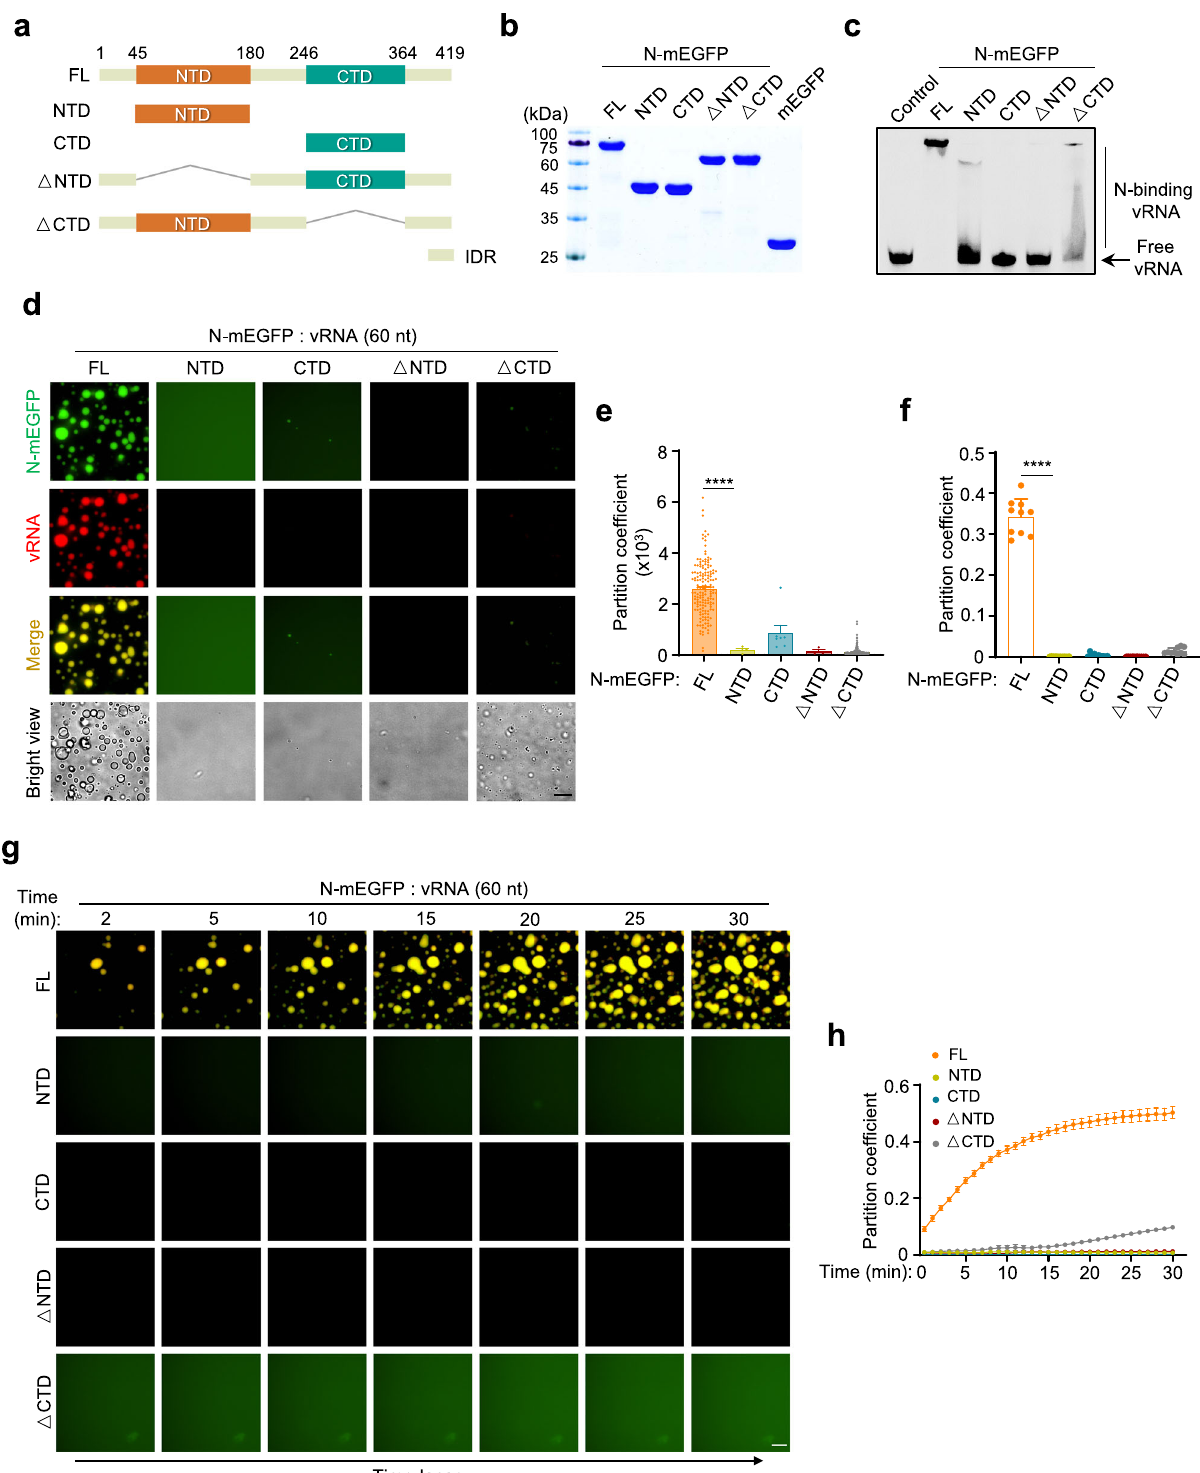
Fig. 3 The LLPS of different N variants. a Schematic drawing of domains of N protein. b Coomassie brilliant blue-stained SDS-PAGE gel of puri fi ed mEGFP protein, and full length and truncations of N-mEGFP protein. c The RNA-binding capacity of full length and different truncations of N-mEGFP protein (1 μ M) was analyzed by EMSA. 55-nt Cy3-labeled vRNA (200 nM) was used as RNA probe. Control, mEGFP protein. d – f LLPS of full length and different truncations of N-mEGFP protein (20 μ M) in the presence of Cy5-labeled 60-nt vRNA (100 ng/ μ l). The partition coef fi cient of fl uorescence intensity per droplet ( e ) and the partition coef fi cient of total fl uorescence intensity in each view ( f ) were calculated. From left to right, n = 1418, 23, 47, 11, 852 droplets ( e ) from 10 randomly selected views ( f ). g , h Time-lapse imaging of full length and different truncations of N-mEGFP protein (20 μ M) in the presence of Cy5-labeled 60-nt vRNA (100 ng/ μ l) ( g ), and the partition coef fi cient ( n = 8 randomly selected views) of total fl uorescence intensity ( h ). Scale bars, 10 μ m ( d , g ). Error bars, mean with s.d. ( e , f ) and mean with s.e.m. ( h ). Two-tailed unpaired Student ’ s t -test ( e , f ), **** P < 0.0001. Data are representative of at least three independent experiments. Source data are provided as a Source Data fi le. NATURE COMMUNICATIONS| (2021) 12:2114 |https://doi.org/10.1038/s41467-021-22297-8|www.nature.com/naturecommunications